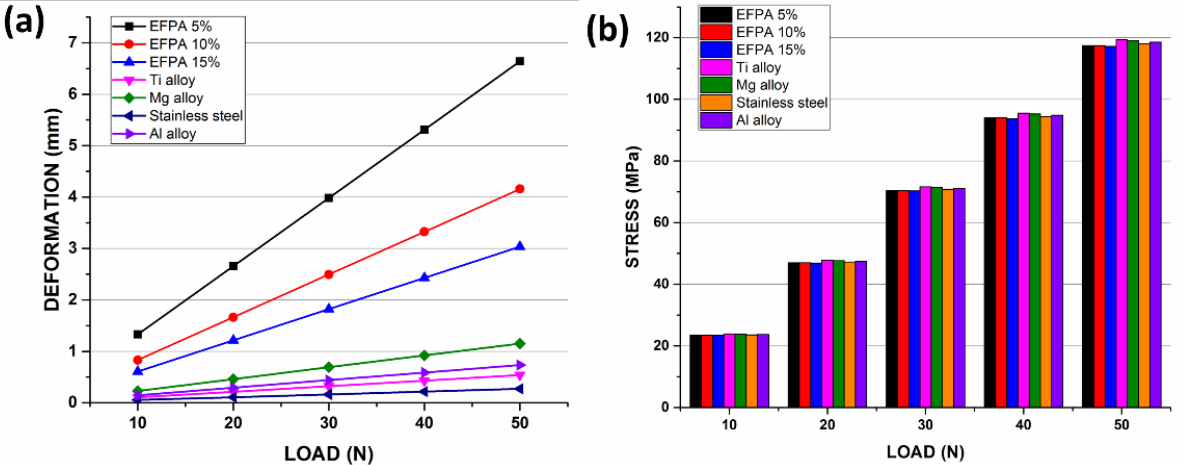
Figure 5. Graphs of Mode-1 showing ( a ) maximum stress vs. load and ( b ) maximum deformation vs. load.